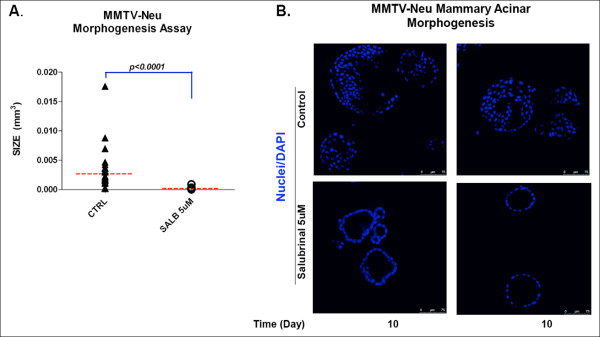
Salubrinal normalizes the deregulated acinar morphogenesis of MMTV-Neu mammary tumor cells. Single epithelial cells isolated from MMTV-Neu mouse mammary tumors were grown in 3D organotypic/Matrigel cell culture over a period of 10 days. (A) Size of vehicle control (CTRL) and salubrinal 5 ug/ml treated acini was calculated following the equation [(Length × width2)/2 = acini volume (mm3)] and plotted; Mann Whitney test p < 0.0001, n = 30. (B) Representative confocal images of equatorial sections through control and salubrinal treated MMTV-Neu acini stained with DAPI at day 10 in Matrigel. Salubrinal treatment reverted the tumorigenic phenotype of MMTV-Neu acini by promoting formation of normal lumens in growth arrested acini (lower panel) as compared to untreated acini showing luminal filling and increased size (upper panels).